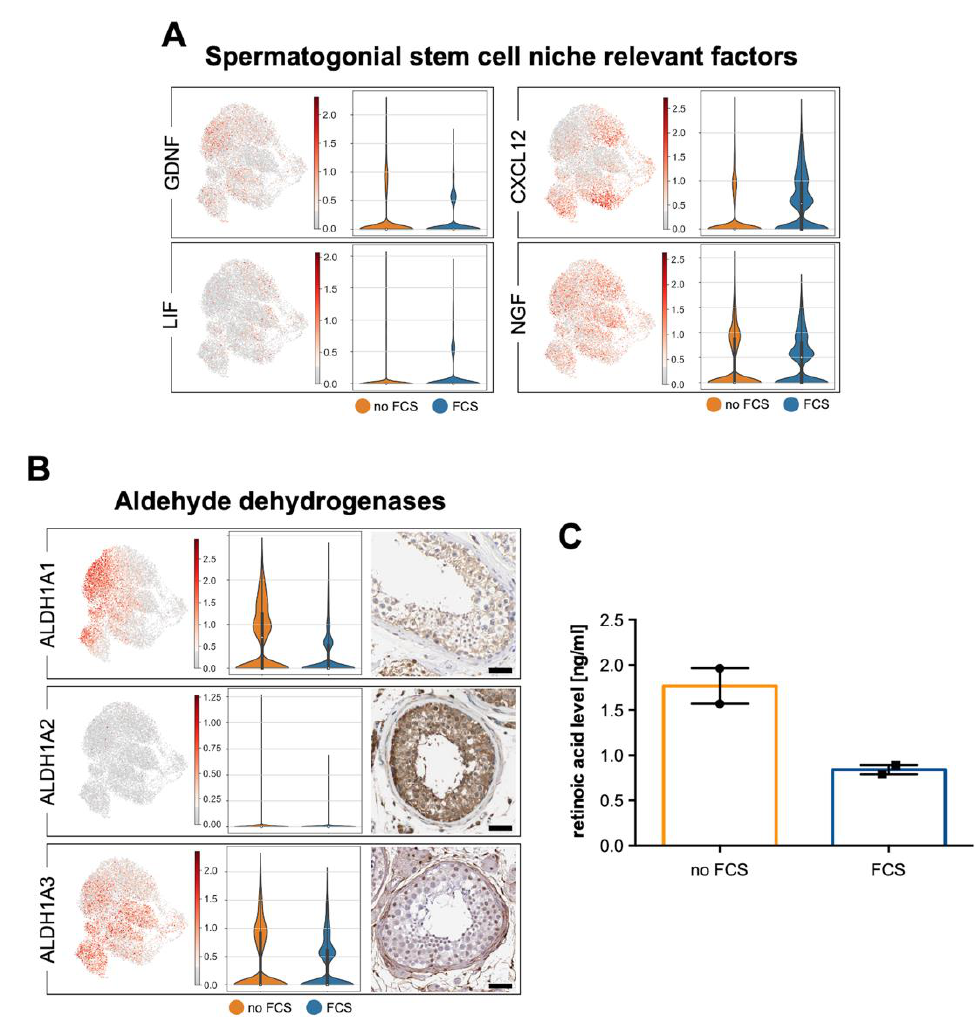
Figure 6. Summary of factors relevant for spermatogenesis. ( A ) UMAP plots of GDNF , LIF , CXCL12 and NGF in HTPCs ( left side ) and corresponding violin plots comparing expression with and without FCS of HTPC-1 ( right side ). ( B ) Transcript detection of the aldehyde hydrogenases ALDH1A1 and ALDH1A3 . Violin plots comparing expression with and without FCS of HTPC-1 ( middle ) and corresponding protein detection with HPA images ( right side ; scale bars = 50 µ m). ALDH1A2 is not expressed in peritubular cells, in vitro or in situ. A comparison between HTPCs and ex vivo data is provided in Table A3 (Appendix B) ( C ) Result of retinoic acid level in HTPCs culture medium (2 samples). We note a decrease in the presence of FCS in the culture medium.